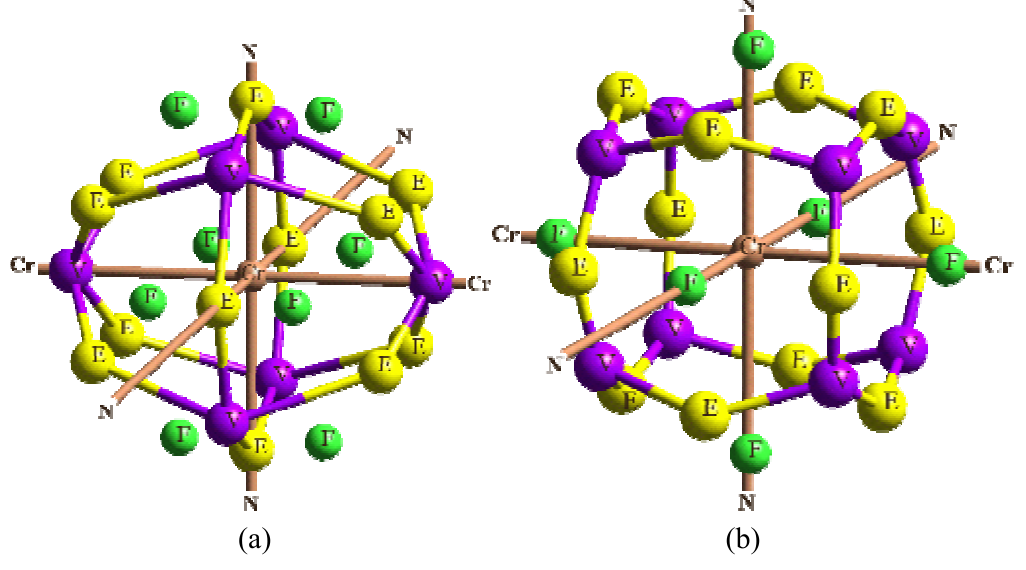
Figure 8 Atomic graphs of the Cr ion. (a) is the atomic graph of Cr(1) ion in Cr topology of the Laplacian for the Cr ions bonded to amide nitrogen atoms. (b) is the atomic graph of Cr(1) ion in Cr to show that for the Cr ions bonded to pyridine nitrogen atoms. The nitrogen atoms of 7 amides are capped to the edge of the polyhedron formed by the valence shell of the Cr ion, but the nitrogen atoms of pyridines are inserted to the face of the